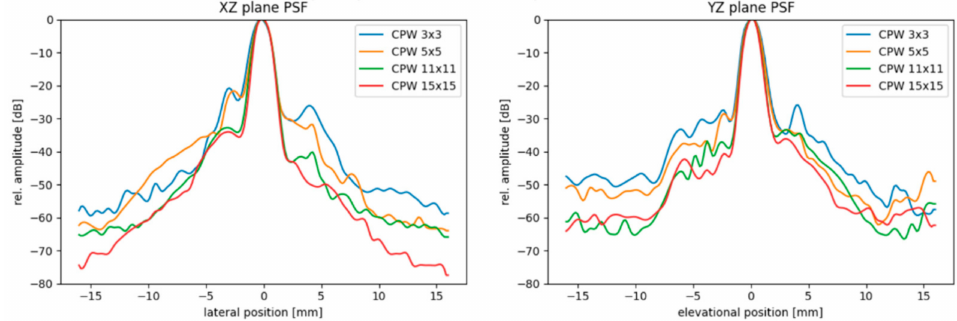
Figure 15. Point spread function of the Vermon 32 × 32 element transducer in the XZ and YZ imaging plane after volumetric reconstruction using volumetric plane wave compounding with 9, 25, 121 and 225